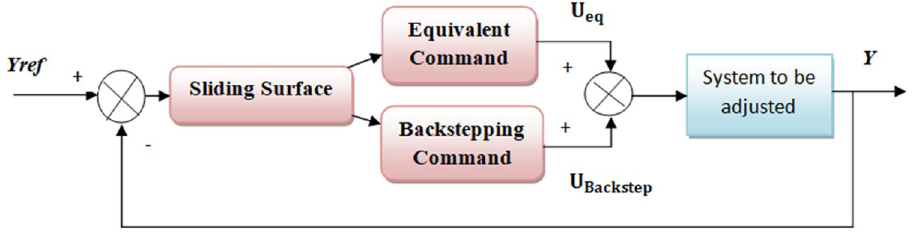
Figure 2. Structure of the Sliding-Backstepping Mode